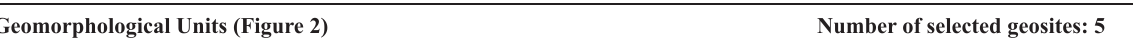
Geological frameworks with justification for scientific value, number of geosites and tectonic-stratigraphy units. Justification for Scientific Value Geomorphological Units (Figure 2) Number of selected geosites: 5